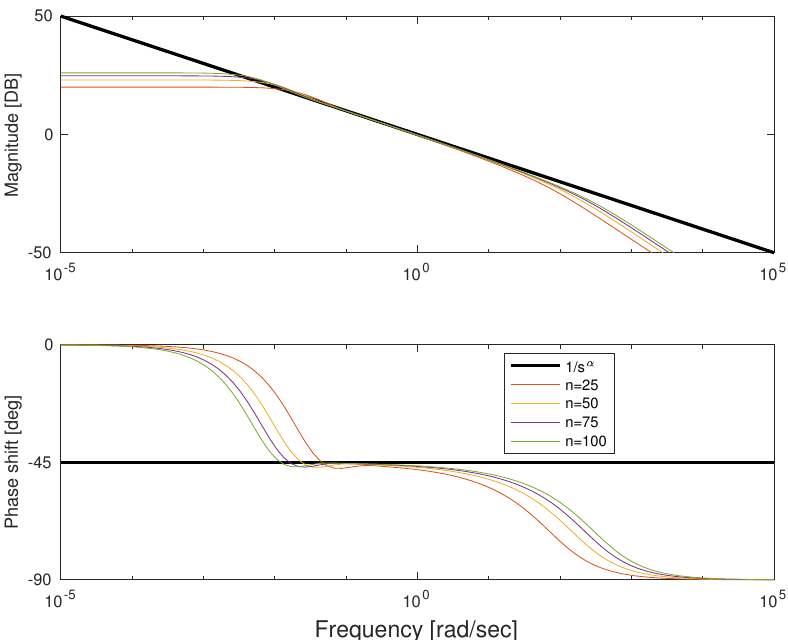
Figure 5. Bode plot for approximation order 25 to 100 for Gauss–Laguerre